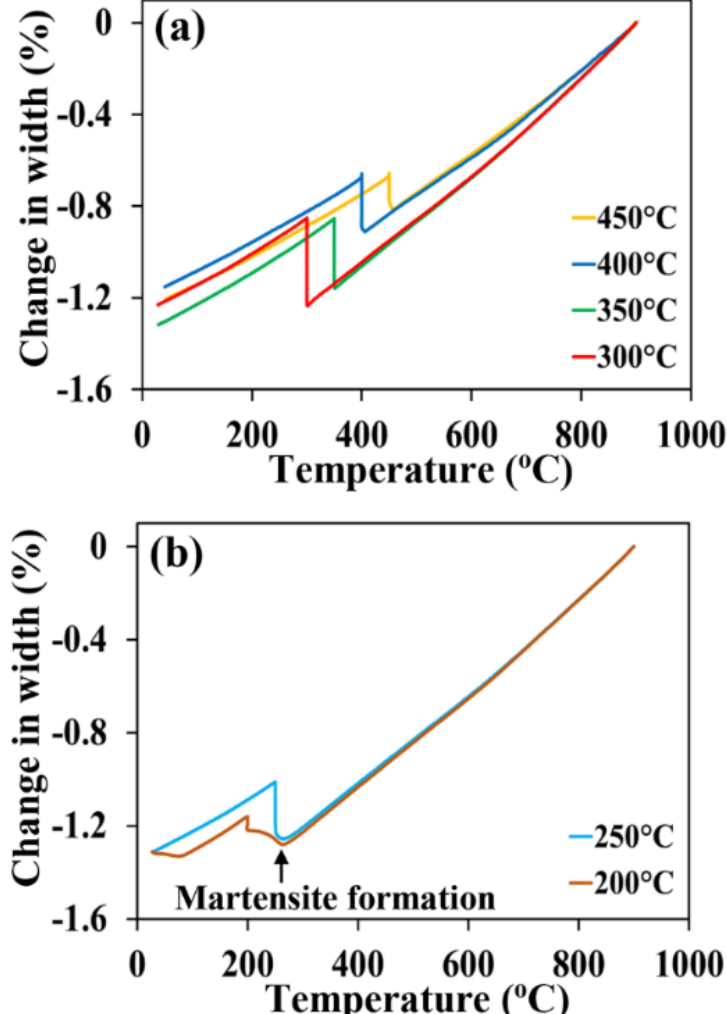
Figure 2. Dilatation curves reveal phase transformation occurring during cooling at 50 °C/s and holding at different temperatures and corresponding changes in specimen width: ( a ) Q&B and ( b ) Q&P treatments.